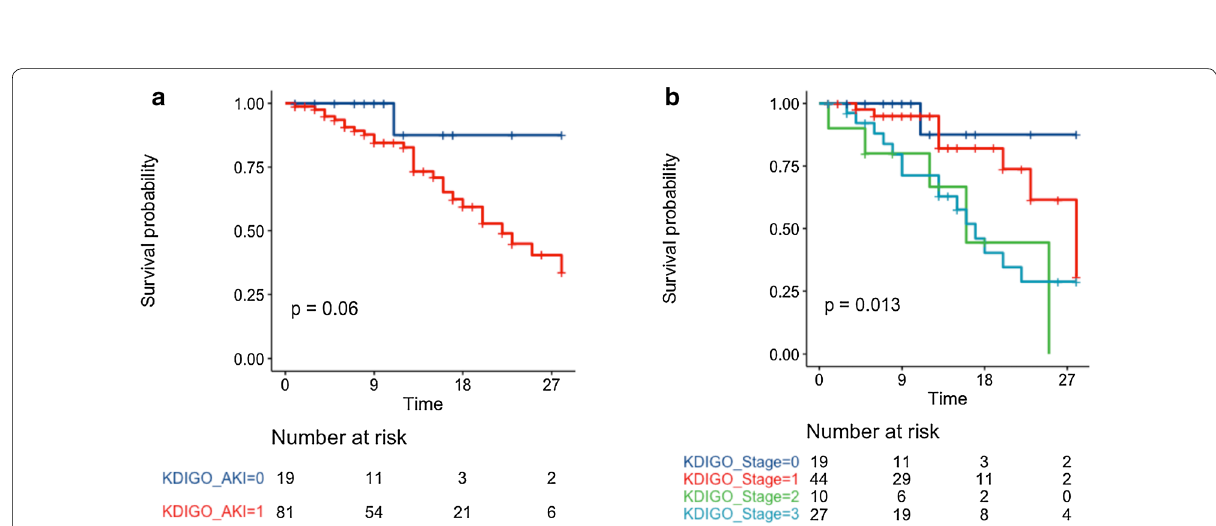
Fig. 2 Kaplan–Meier curves for day-28 survival in patients with ( n ( n 27) ( b =